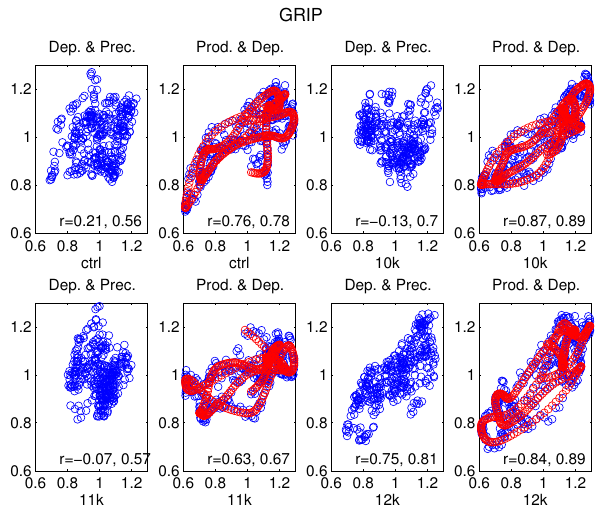
Fig. 13. Same as Fig. 12 but for the Law Dome Fig. 12. In blue: Scatter plots and correlation coefficients (first numbers) between variables (production: ’Prod.’, deposition: ’Dep.’ and precipitation: ’Prec.’) of 25-month running means at the GRIP station. In red: Scatter plots and correlation coefficients (second numbers) between the noise-filtered (IMFs 4-8) production and deposition.